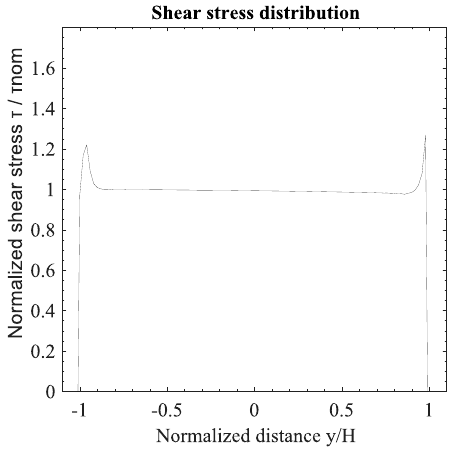
Fig. 14 Shear stress distribution in the adhesive